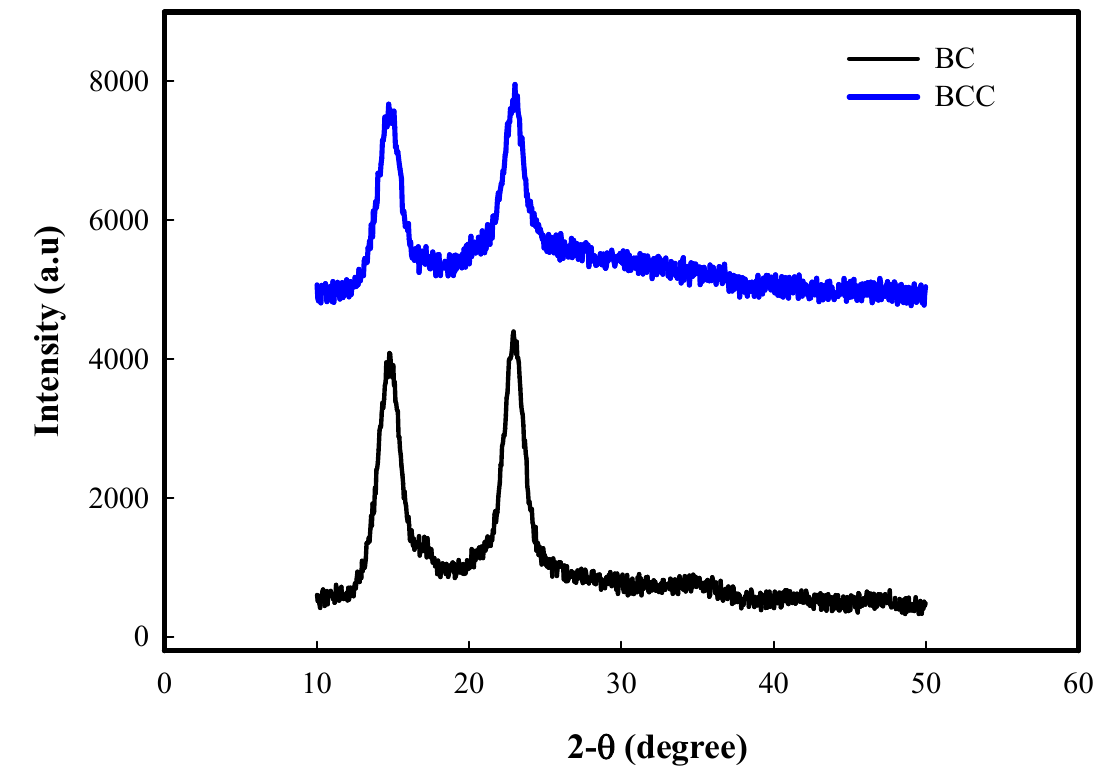
Figure 3. XRD analysis of BC, and BCC composite films.